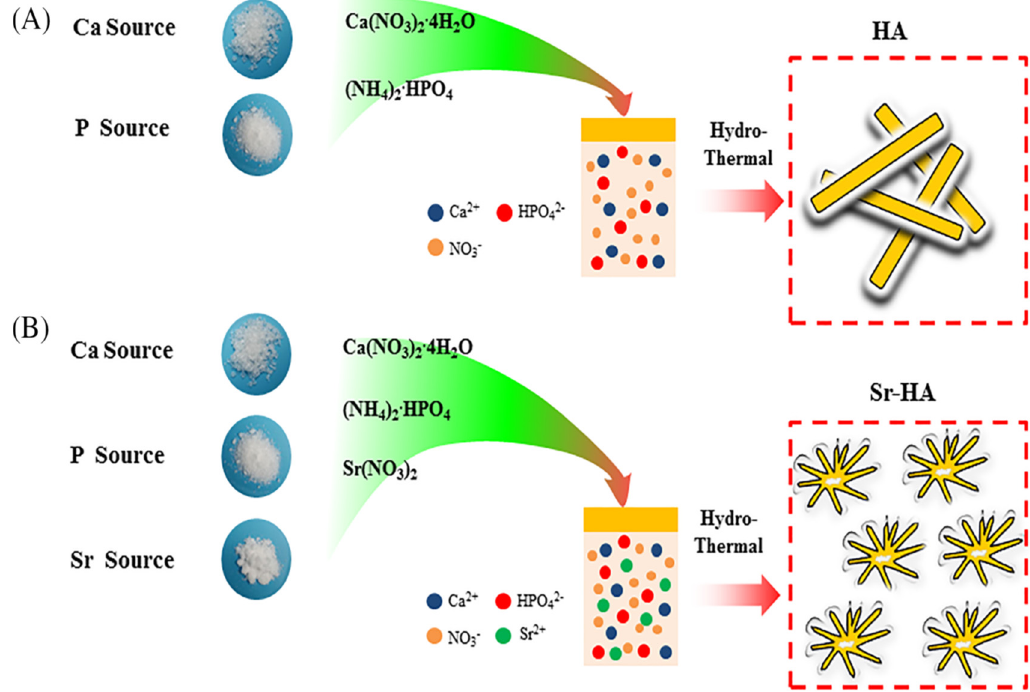
Figure 3. Hydroxyapatite (HAP) synthesis from the Ca and P sources ( A ), and strontium–hydroxyapatite (Sr–HAP) synthesis from the Ca, P and Sr sources ( B ), using the wet chemical method. Reproduced with permission from Jingfeng Li et al., 2018 [155].